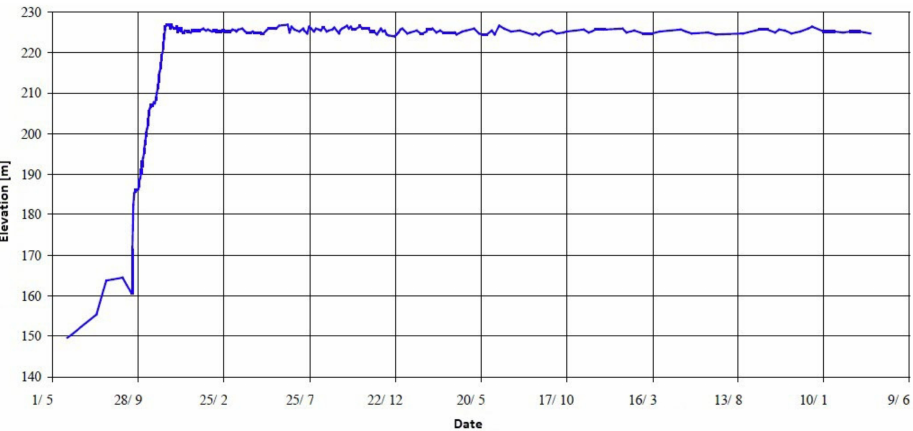
Figure 7. Filling and water level in the reservoir in the exploitation